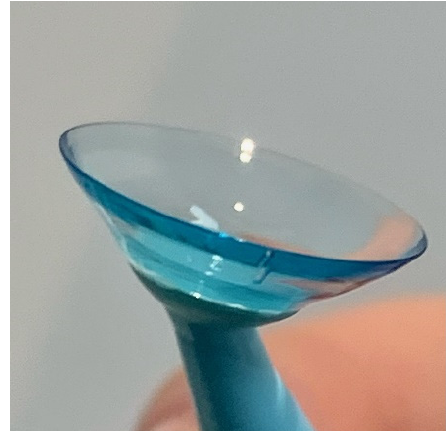
Figure 4. RoseK XL rigid gas permeable lens.